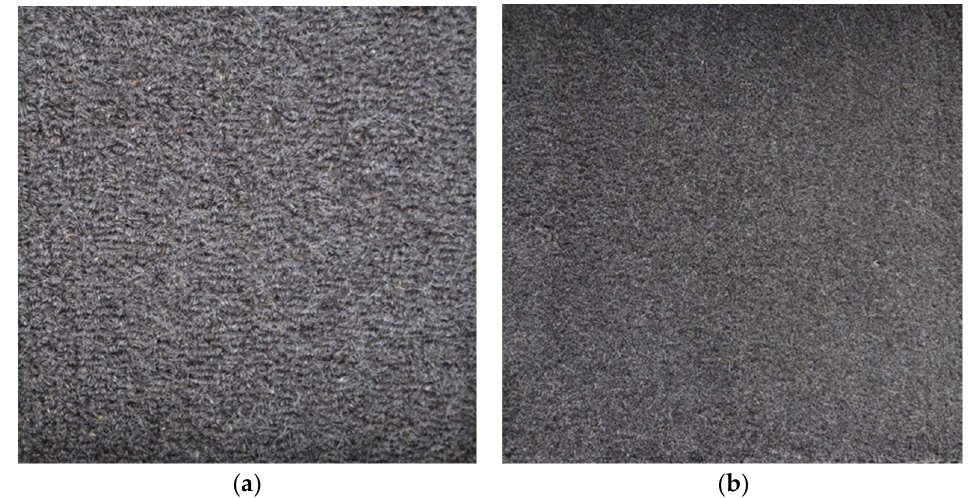
Figure 5. Tufted fabrics manufactured from ring spun yarn; ( a ) loop pile; ( b ) cut pile.